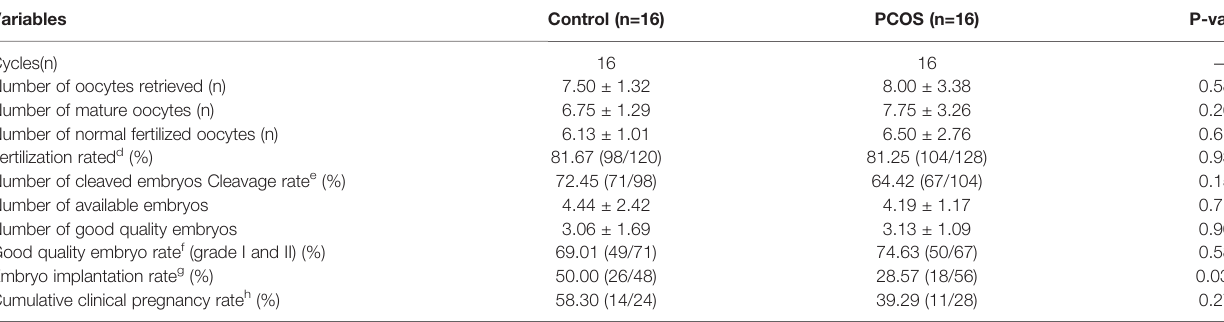
TABLE 4 | Laboratory and pregnancy outcomes of the study participants between control and PCOS group X ±